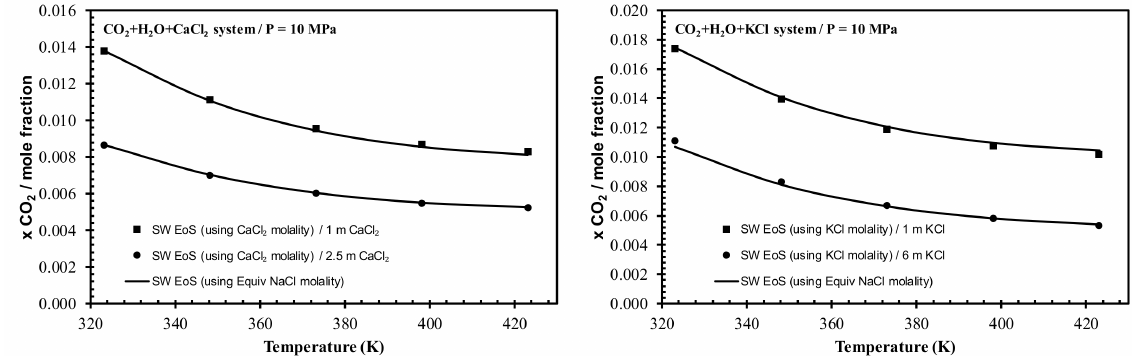
Figure 6. Salt-dependent Kij vs. equivalent NaCl molality using SW EoS.